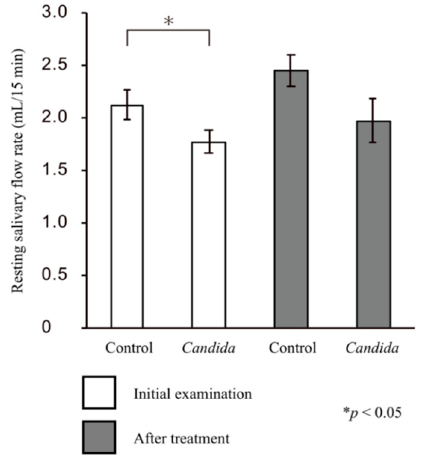
Figure 1. Changes in the resting salivary flow rate. There was a significant difference in the changes in the resting salivary flow rate at the initial visit between the control and Candida groups ( p < 0.05). Although not significant, the changes in the resting salivary flow rate after prosthetic treatment were less in the Candida group than in the control